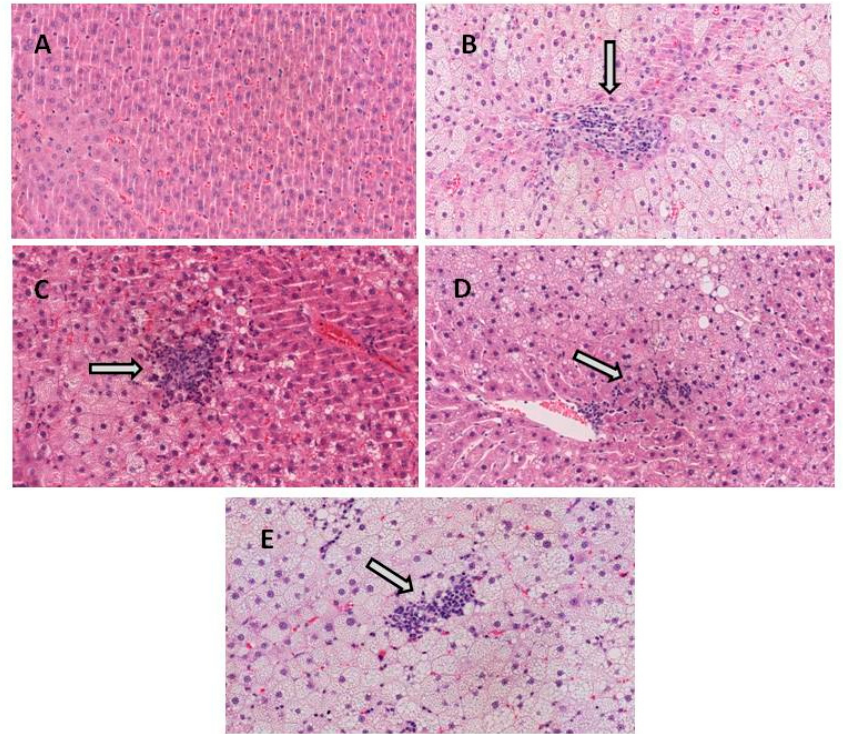
Figure 1. Representative H&E stained histological liver samples (magnification × 20). ( A ) healthy liver from CC group, ( B ) liver from HFHF group showing moderate inflammation and ballooning degeneration, ( C ) liver from PT15 group showing moderate inflammation and ballooning degeneration, ( D ) liver from PT30 group showing mild inflammation and ballooning degeneration and ( E ) liver from RSV30 group showing mild–moderate inflammation and ballooning degeneration. White arrows indicate inflammation.